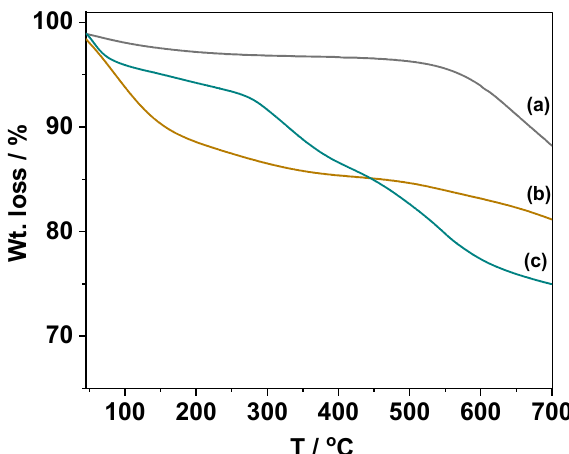
Figure 4. ( A ) XRD patterns; ( B ) N 2 adsorption-desorption of (a) MS@GPTMS NPs and (b) MS@PNIPAm- PAAm NPs; and ( C ) Pore size distributions of (a (cid:48) ) MS@GPTMS NPs and (b (cid:48) ) MS@PNIPAm-PAAm NPs, respectively.